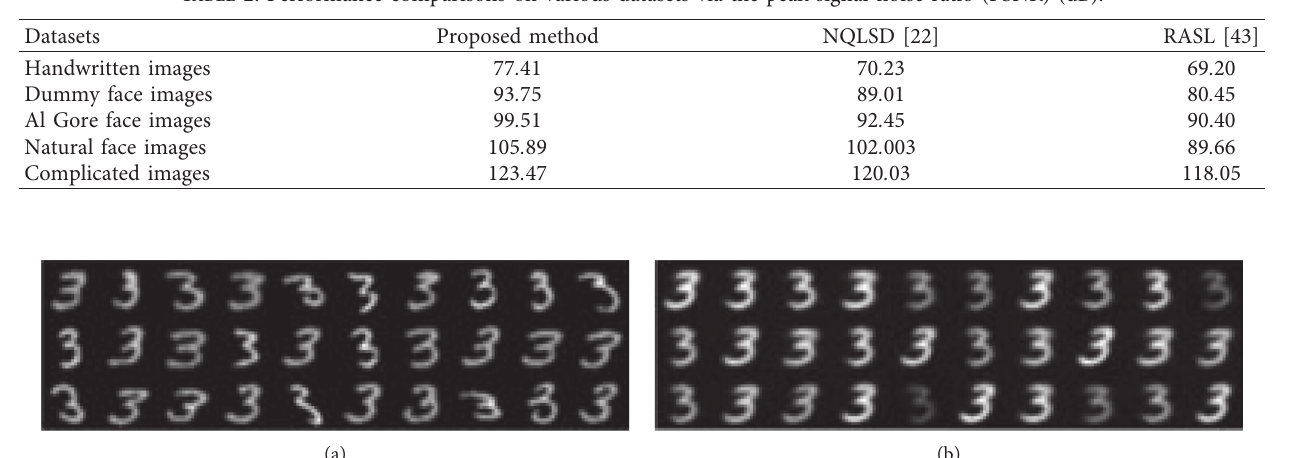
Table 2: Performance comparisons on various datasets via the peak signal-noise ratio (PSNR)